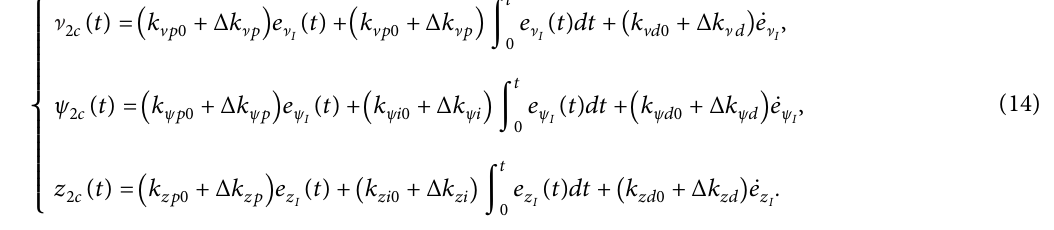
Figure 5: Formation controller